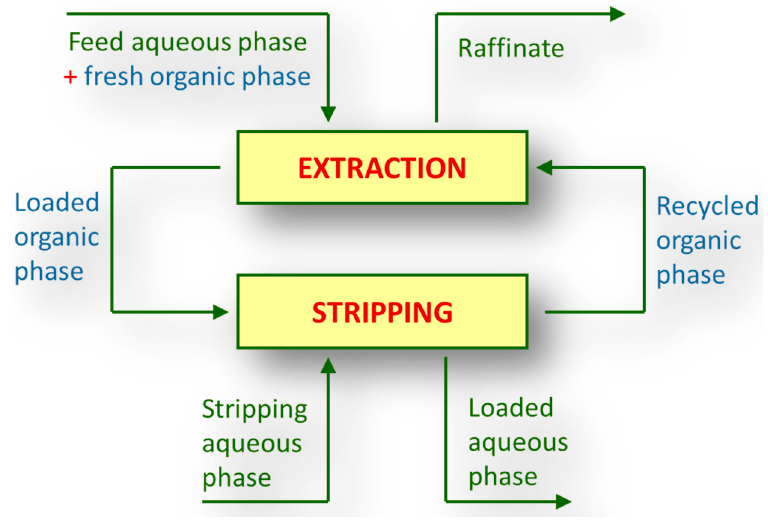
Figure 1. The solvent extraction scheme applied for metals recovery.